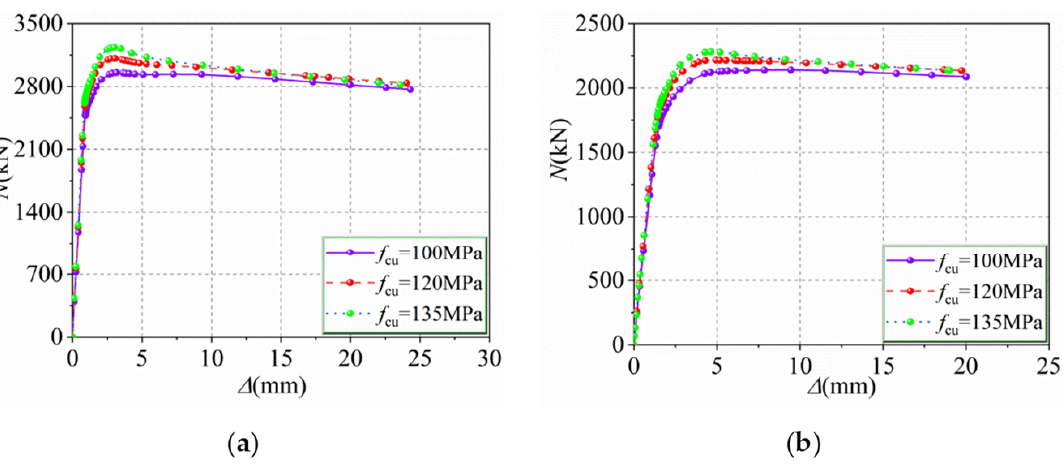
Figure 9. Curves of load–deflection for specimens with various f cu : ( a ) e = 30 mm; ( b ) e = 50 mm.